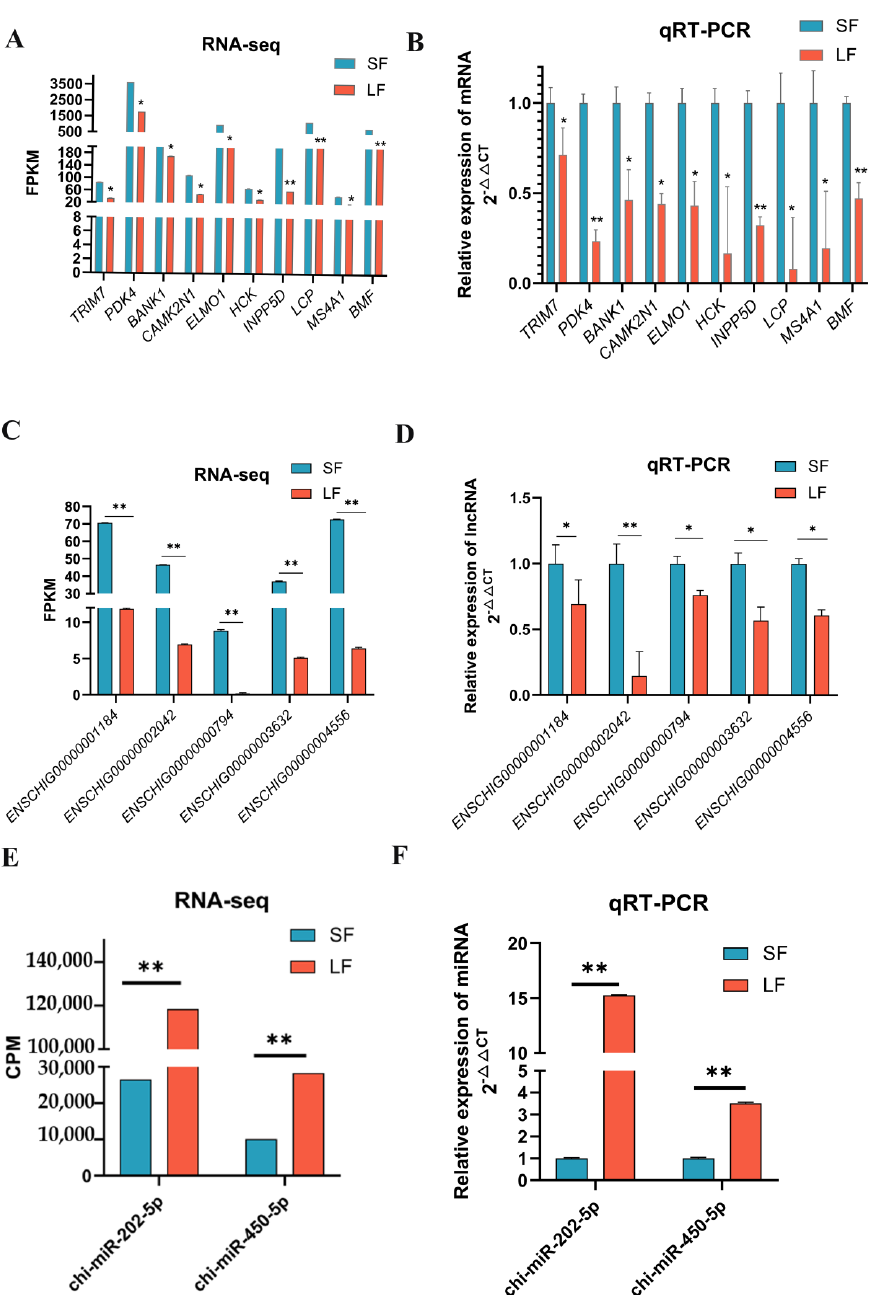
Figure 3. Differentially expressed mRNAs, lncRNAs and miRNAs were verified by qRT-PCR. ( A , B ): The expression levels of the 10 mRNAs were verified by qRT-PCR and compared with the results of RNA-seq. ( C , D ): The expression levels of the five lncRNAs were verified by qRT-PCR and compared with the results of RNA-seq. ( E , F ): The expression levels of the 2 miRNAs were verified by qRT-PCR and compared with the results of RNA-seq. The results were shown to be consistent with RNA-seq data by RT-qPCR. Data are shown as mean ± SD values ( n = 3, * p < 0.05; ** p < 0.01 indicates significant